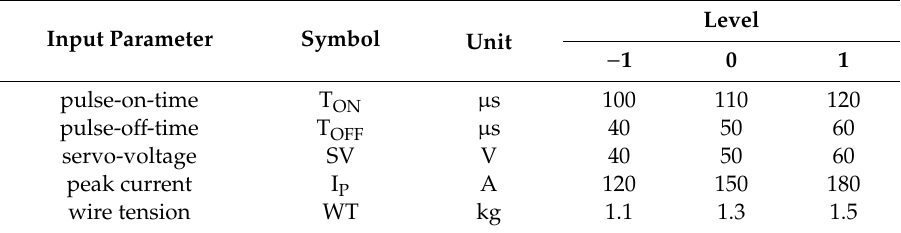
Table 3. Independent control factors, and their